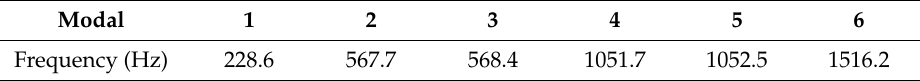
Table 2. The first six mode frequencies of the tunnel magnetoresistive